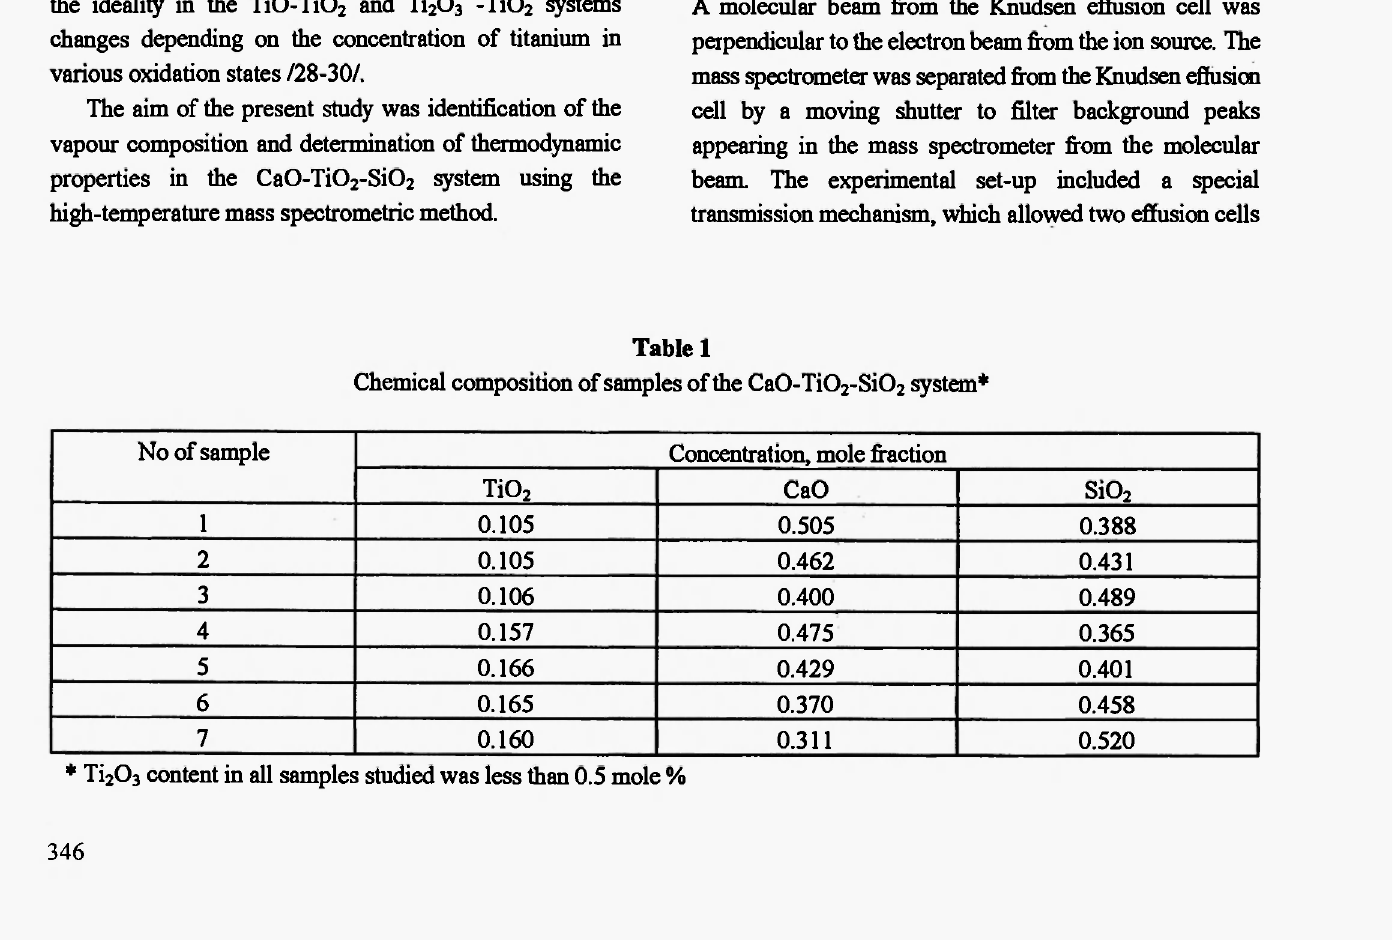
Chemical composition of samples of the Ca0-Ti0